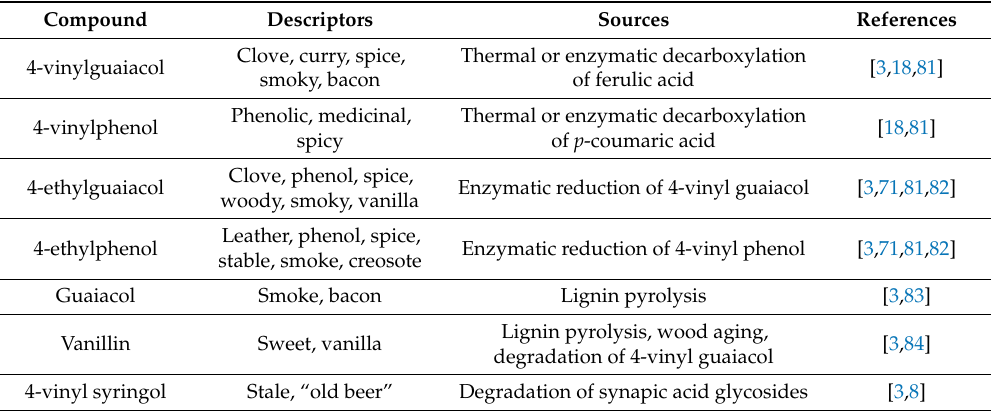
Table 1. Flavor and aroma descriptors for common volatile